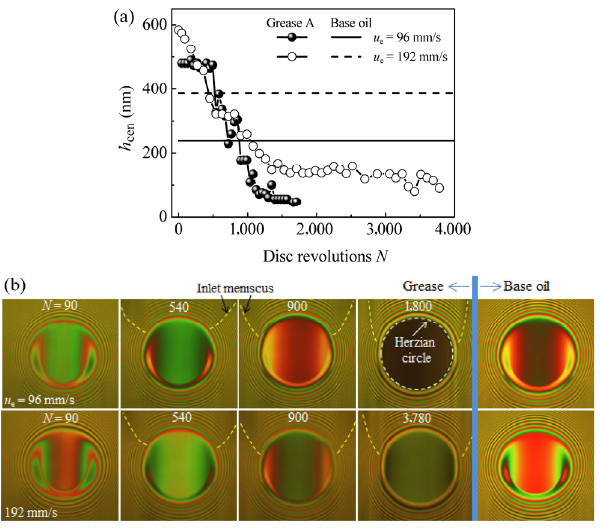
Fig. 5 Evolution of EHL films against disc revolutions at moderate speeds, Grease A. (a) Variations of film thickness with disc revolutions; (b) interference images.